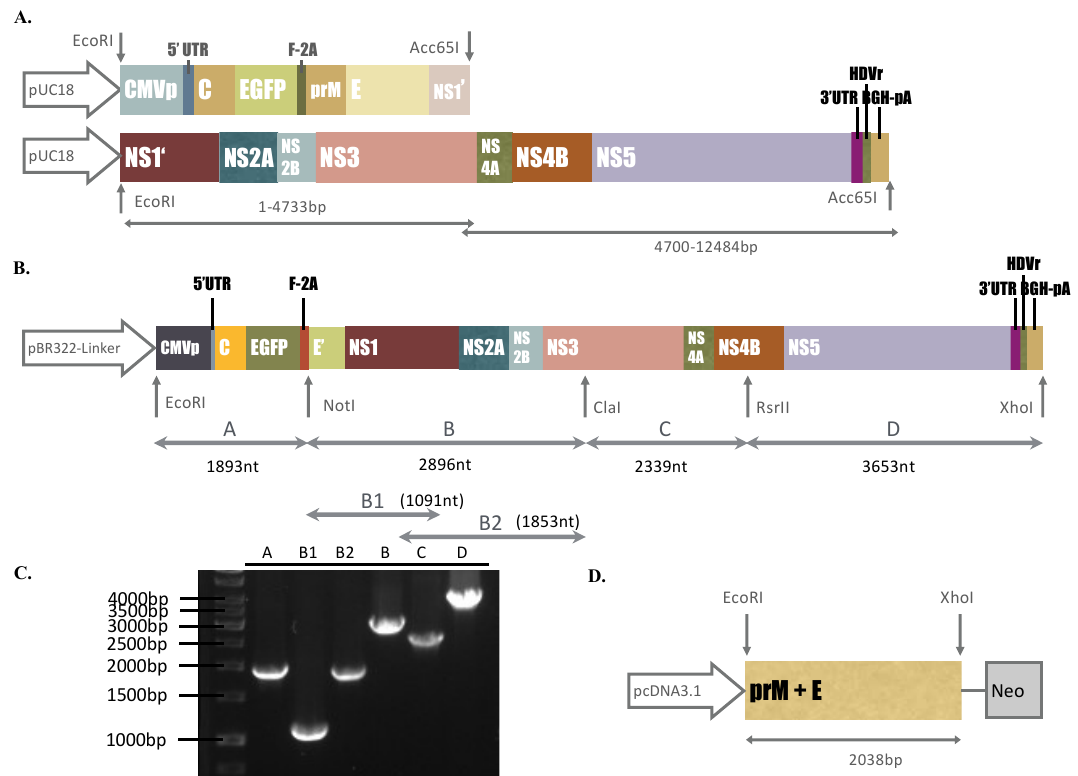
Figure 1. Construction of the pBR322-based ZIKV Natal RGN replicon and pcDNA3.1-ZIKV prME. Two synthetic DNA segments in the pUC18 plasmid contained the entire ZIKV Natal RGN strain genome: CMVp, EGFP, FMDV-2A, and BGH-pA sequences ( A ). Four PCR products (Fragments A–D) were cloned into the indicated restriction sites (EcoRI, NotI, ClaI, RsrII, and XhoI) of the pBR322 plasmid and then assembled as the in-frame fusion of the ZIKV Natal RGN replicon with the EGFP reporter under CMV-promoter control ( B ). Those four PCR products were analyzed using agarose gel electrophoresis ( C ). The PCR product of ZKIV prM and E genes was cloned into restriction sites (EcoRI and XhoI) of the pcDNA3.1-His-C plasmid ( D ).